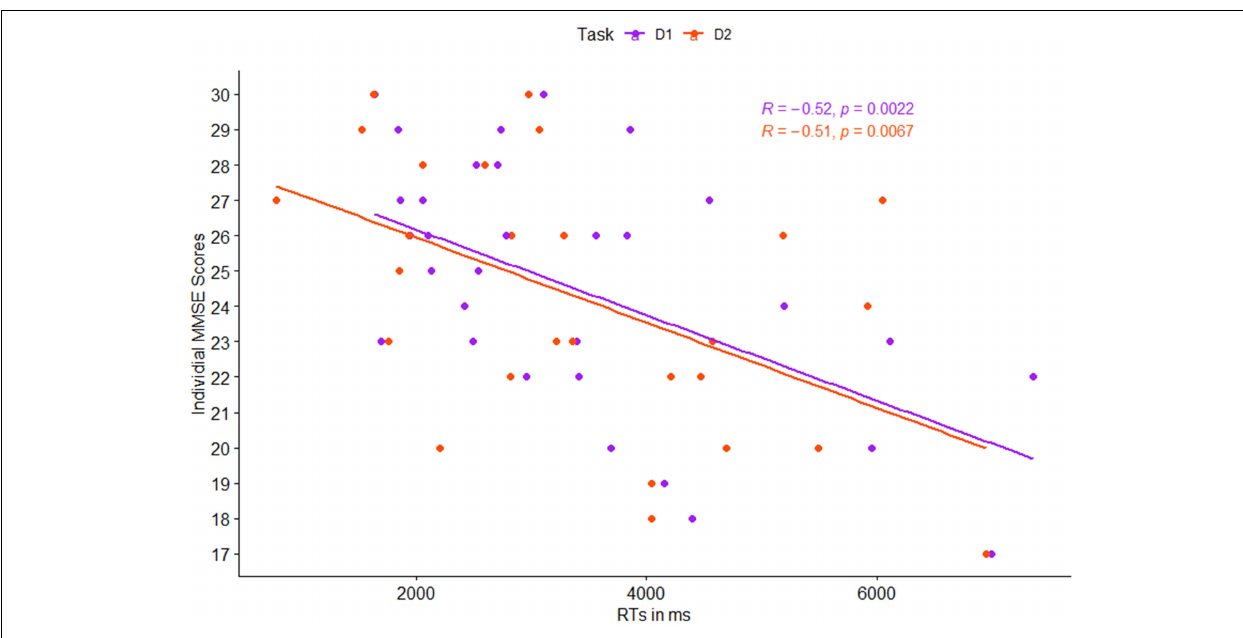
FIGURE 3 | Pearson correlation between individual mean reaction times (RTs) and individual MMSE scores, as a function of task level: detection 1 (purple) and detection 2 (red).